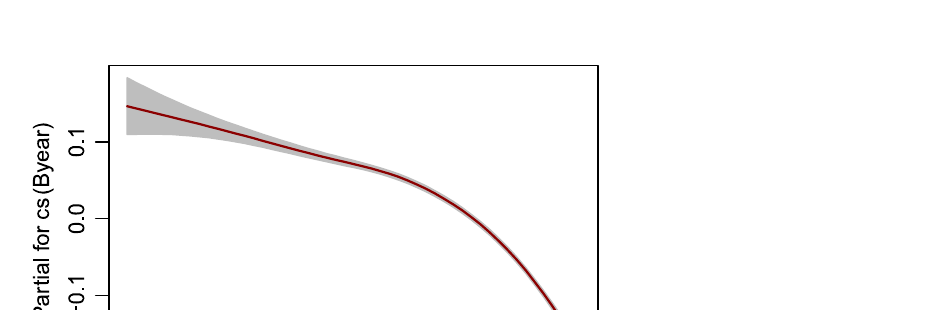
Table 3. Estimated increasing rates per year (in days) of the median AaM.